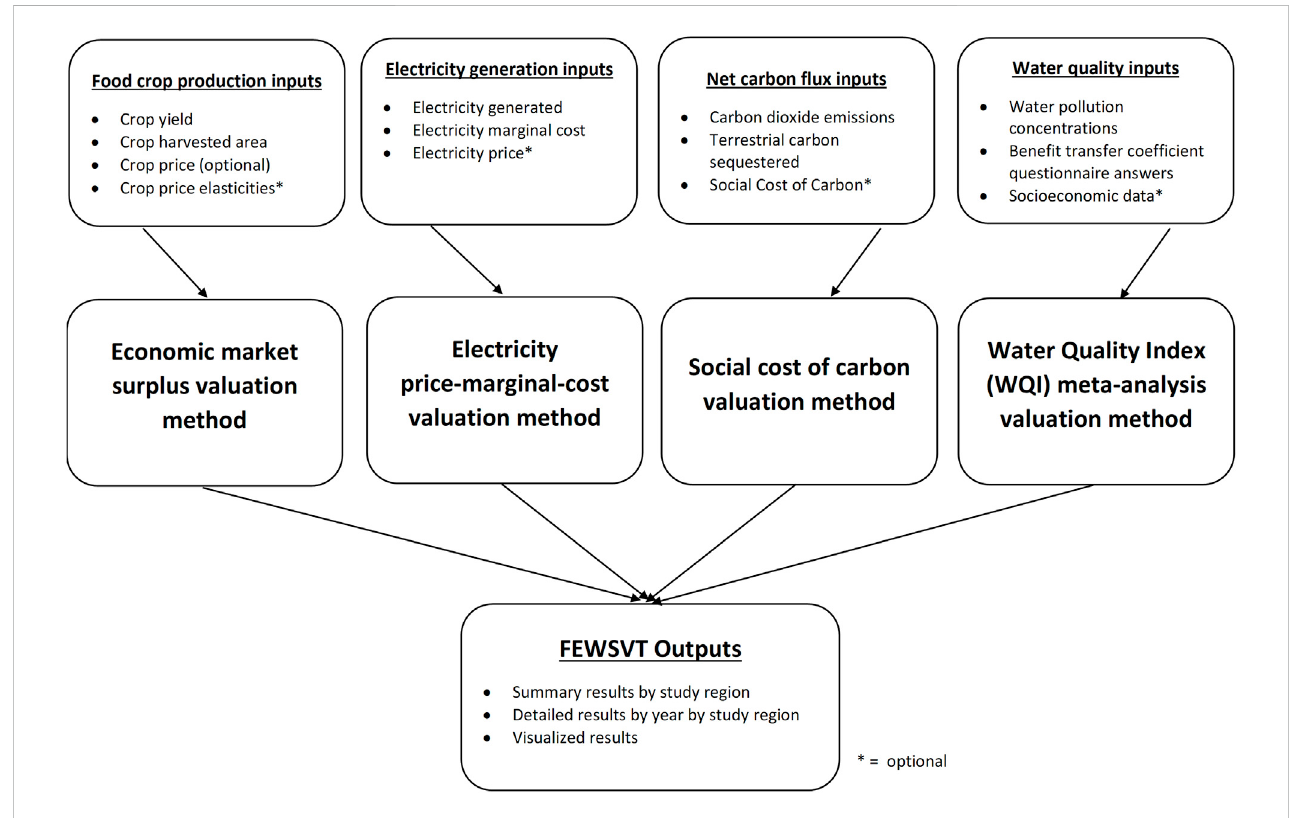
FIGURE 1 FEWSVT process fl ow